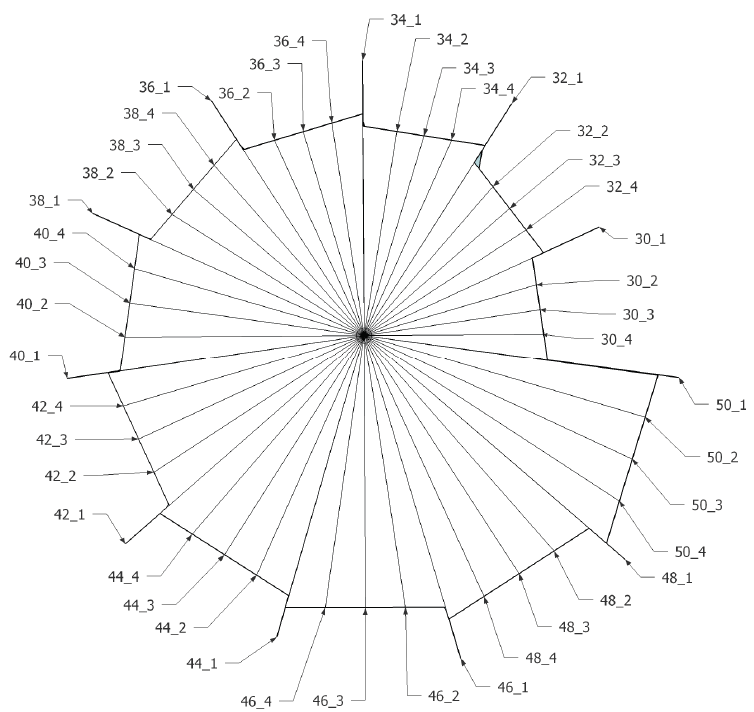
Figure 13. Direction index. ##_% denotes that ## is radial length and % is